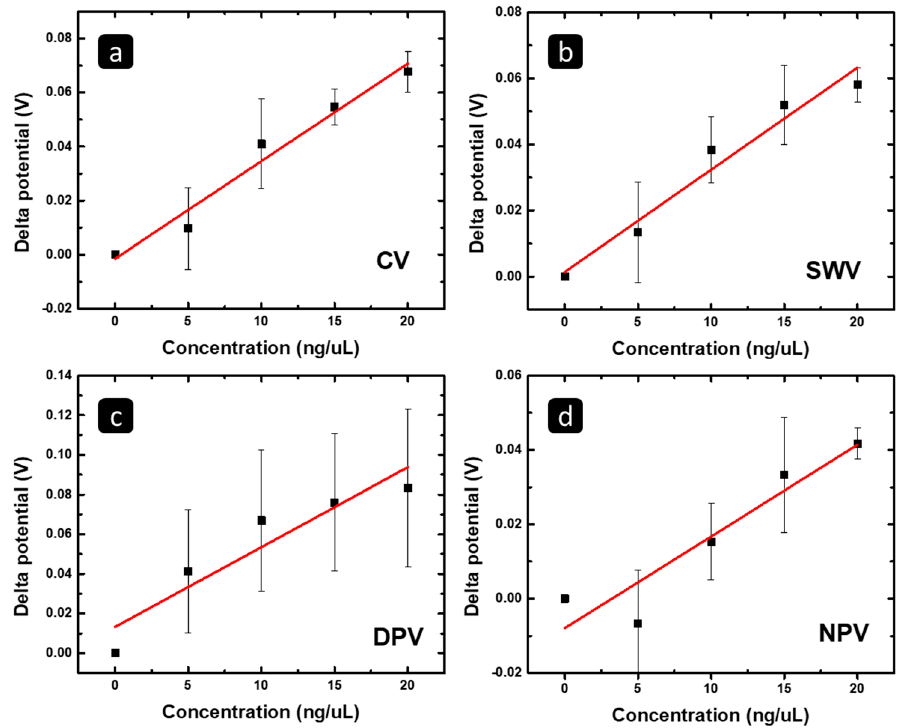
Figure 6. The correlation between the ( a ) CV, ( b ) SWV, ( c ) DPV, and ( d ) peak potential change versus the concentration of the MCF7 exosomal RNA, using the concentration range of 0 − 20 ng/µL, in which a linear behavior is observed.